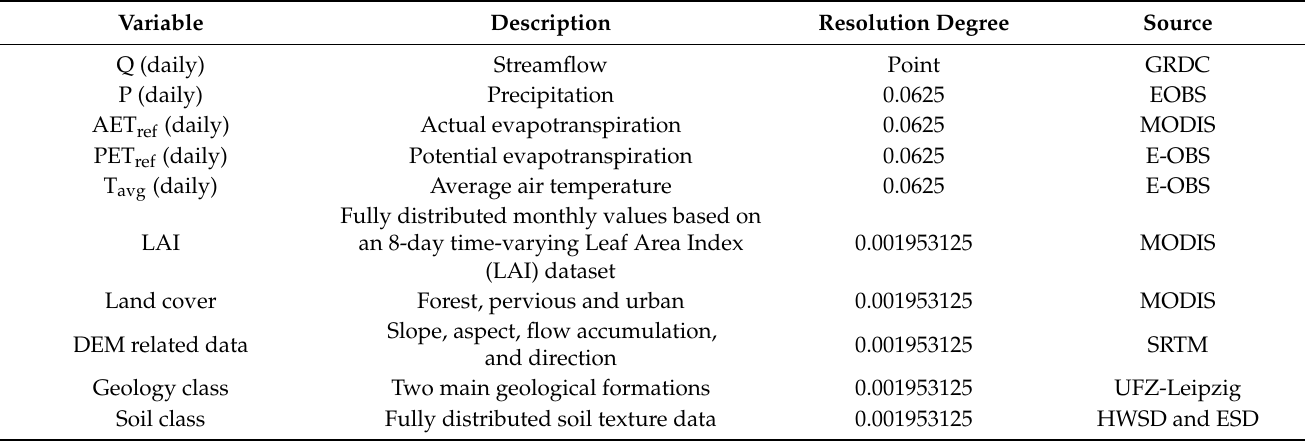
Table 1. Description of morphologic and meteorologic inputs of mHM and their resolution and dataset resources